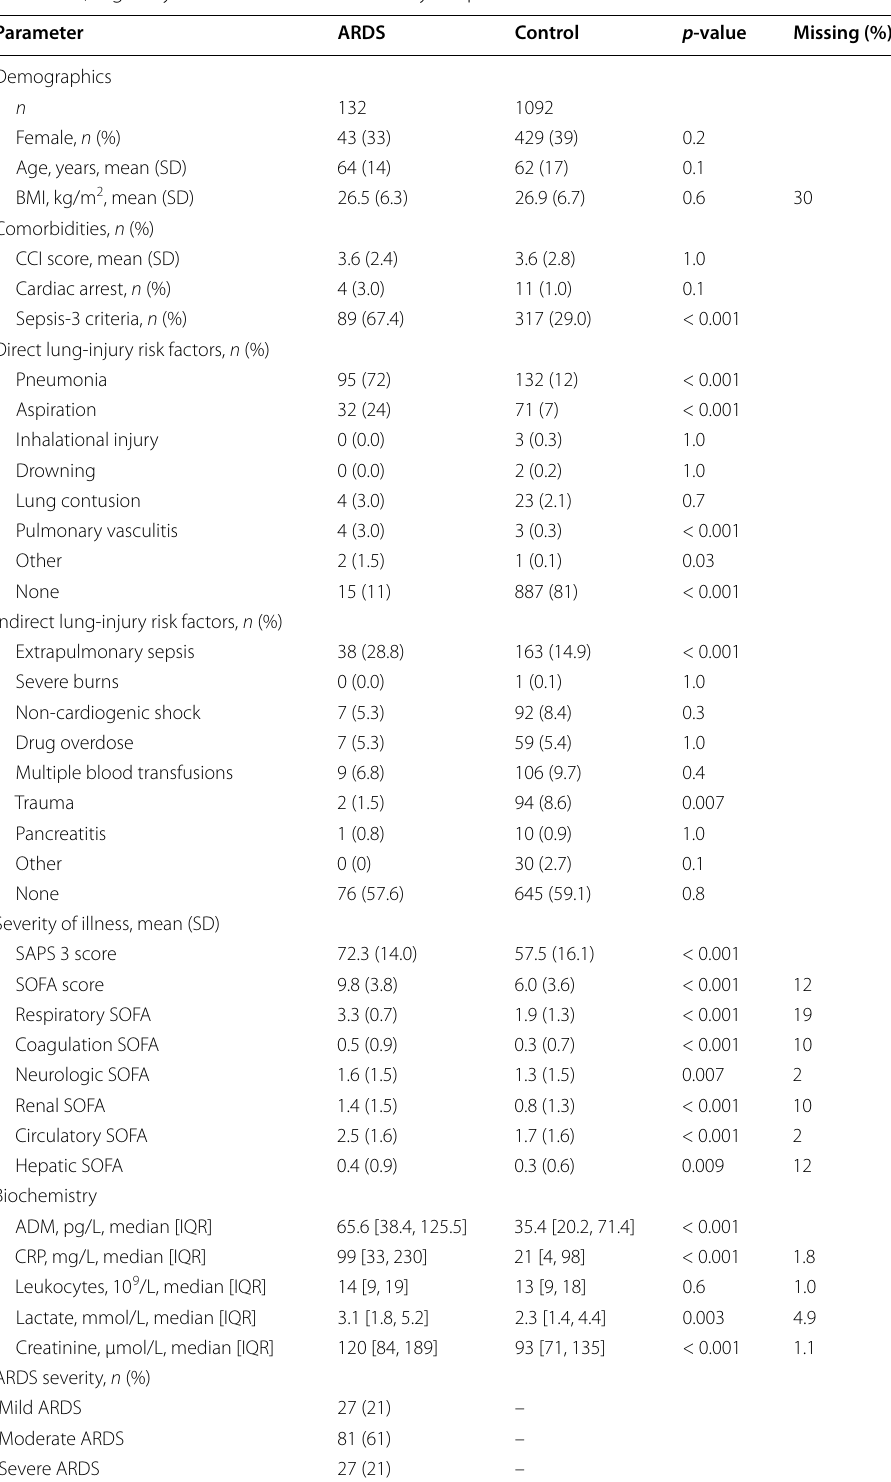
Table 1 Characteristics of ARDS-patients and controls. Data regarding general characteristics, outcomes, organ dysfunction and illness severity are presented below Parameter ARDS Control p